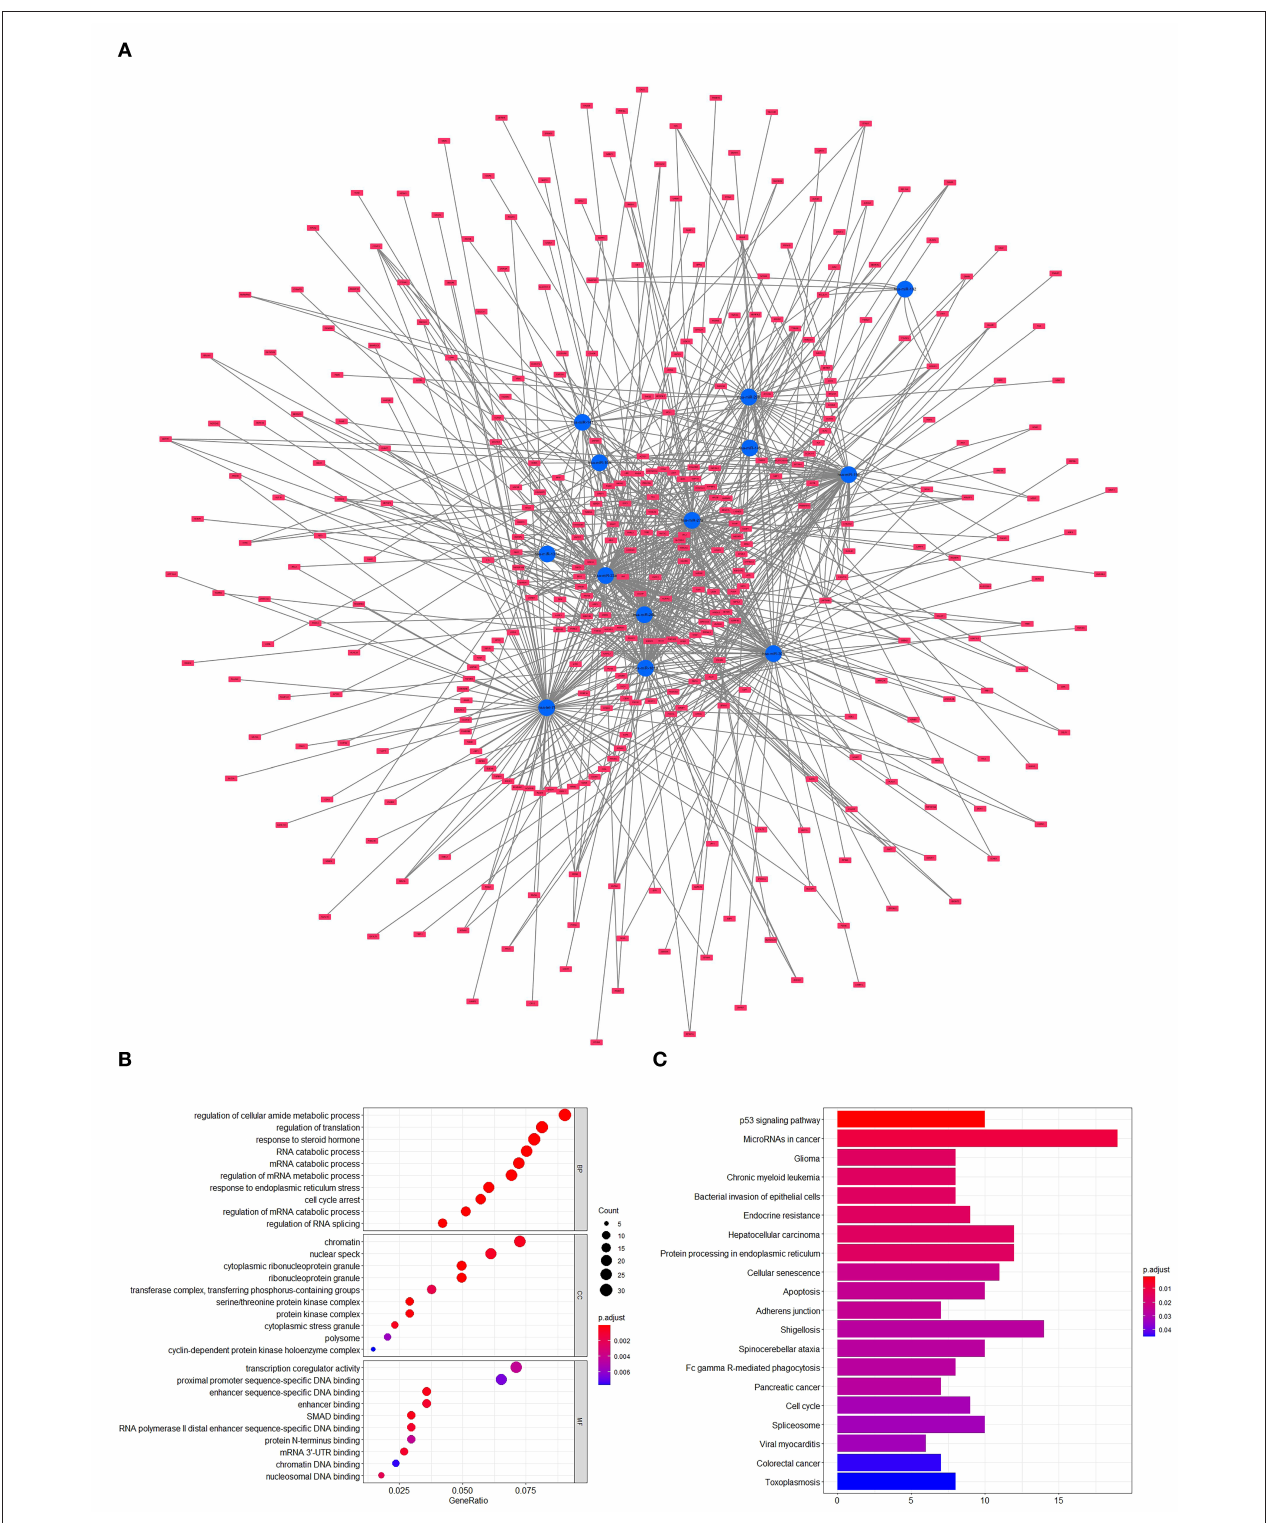
FIGURE 4 | Prediction and analysis of related genes and pathways. (A) Coexpression network of differentially expressed miRNAs and mRNAs. (B) GO analysis of miR-181a. (C) KEGG pathway analysis of miR-181a. GO, Gene Ontology; KEGG, Kyoto Encyclopedia of Genes and Genomes.